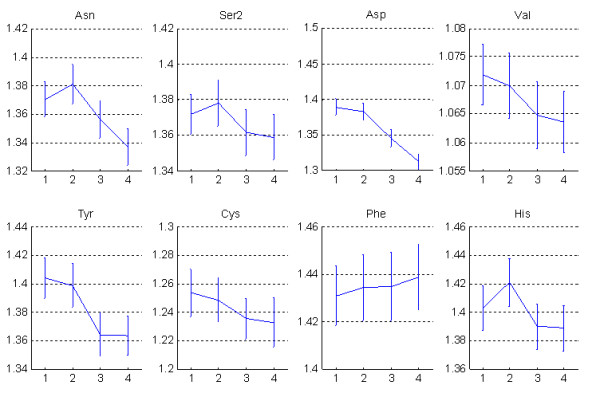
RMCU (vertical axis) of amino acids in Group B vs. breadth of expression. The bins on the horizontal axis represent breadth of expression as follows: bin 1: 1–5, bin 2: 6–9, bin 3: 10–13 and bin 4: 14–20.